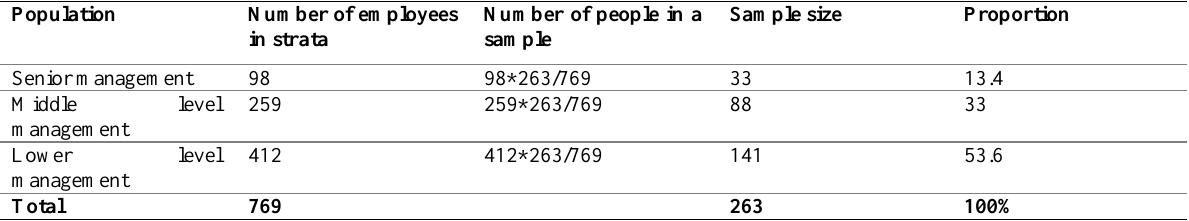
Table 1: Distribution of the sample